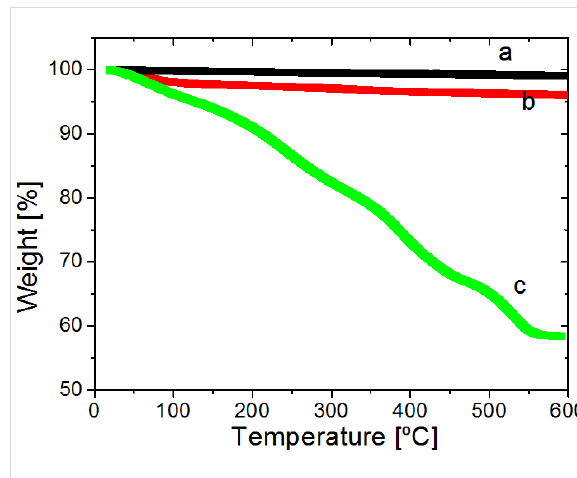
Figure 2: TGA curves of pristine BNNTs (a), oligoperoxide-functionali- zed BNNTs (b) and P(AA- co -FA)-functionalized BNNTs ( с